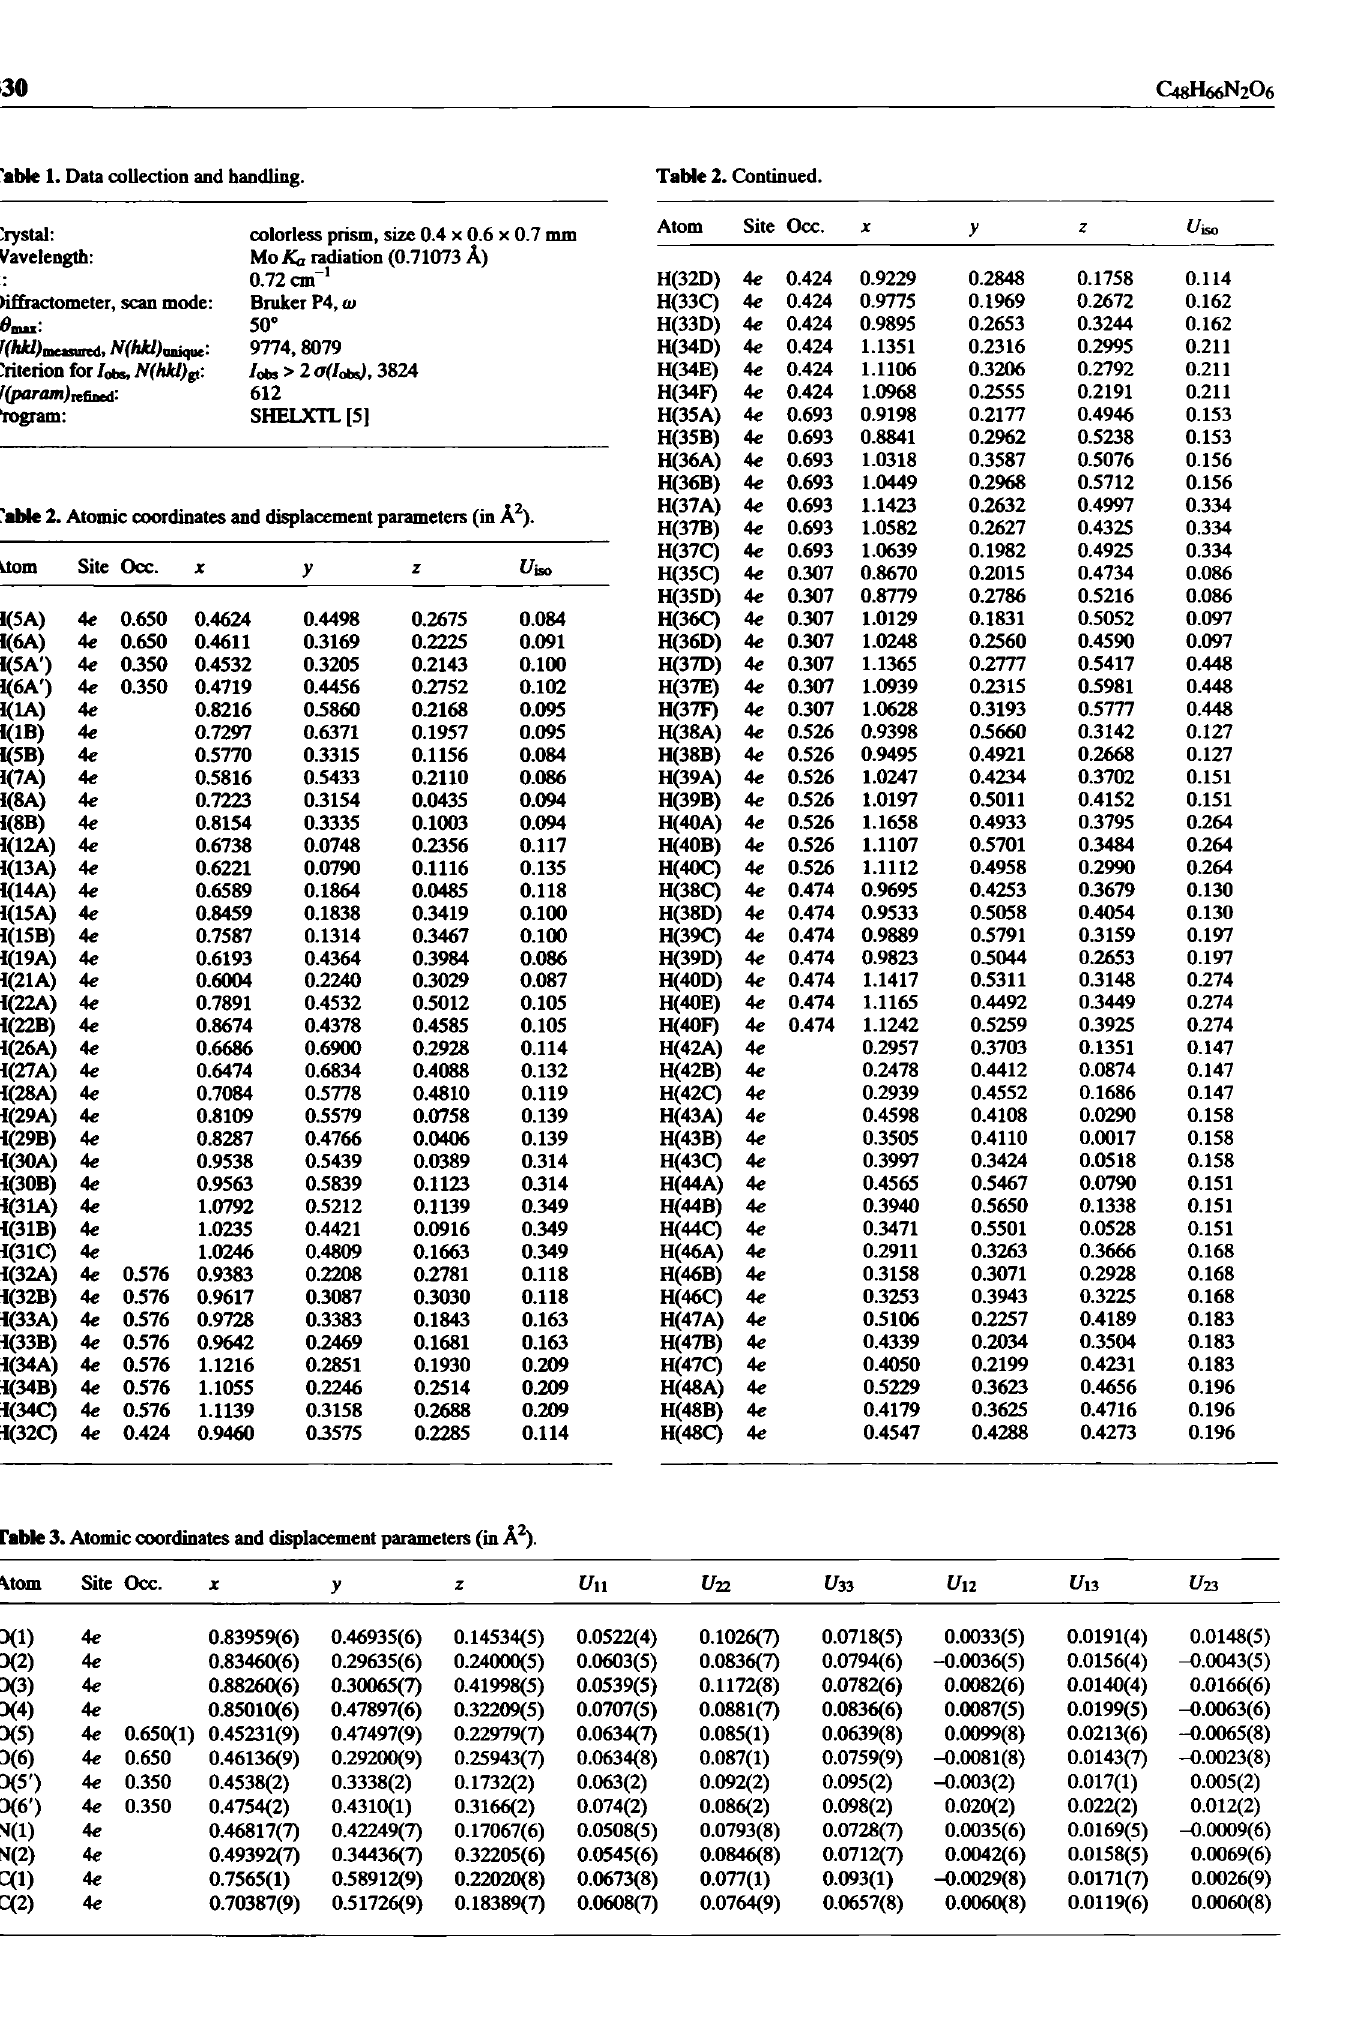
Table 3. Atomic coordinates and displacement parameters (in Ä 2